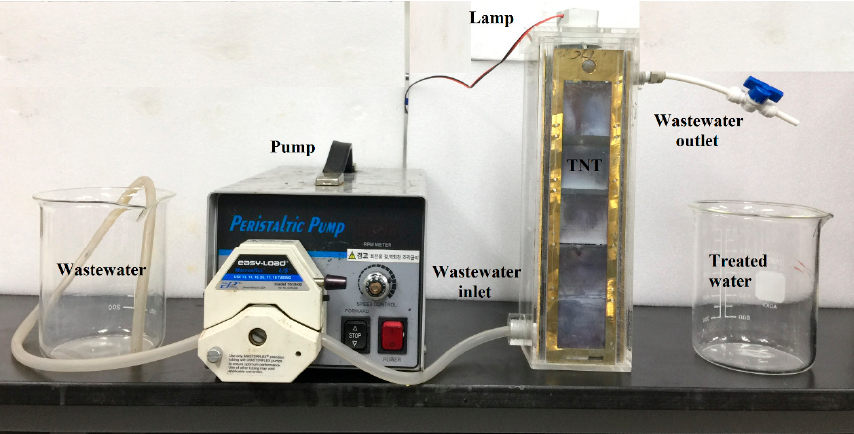
Figure 9. Image of the continuous ‐ flow photocatalytic reactor prepared in the lab.